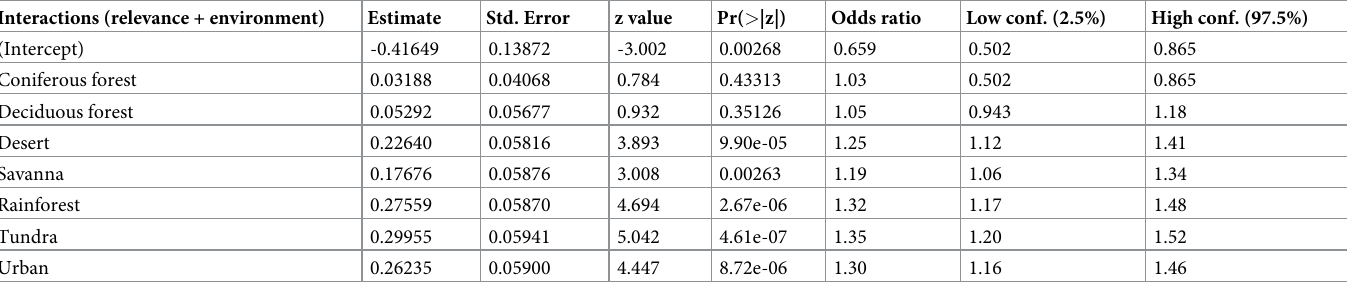
Table 1. Results of binomial GLM, estimated regression parameters, standard errors, z values, p values and effect size (in Odds ratio) estimated for relevance in each of the interactions (environments + relevance) that we used in the model, accompanied with the respective confidence intervals. Interactions (relevance +